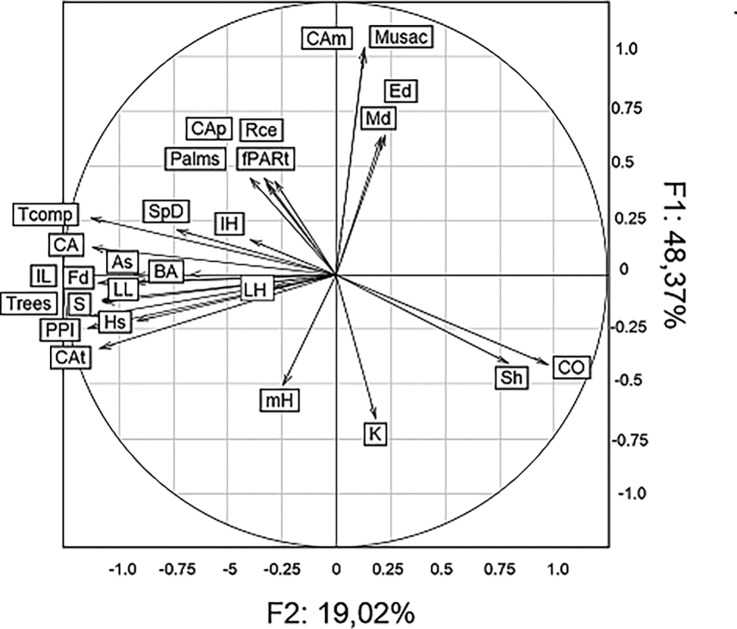
Representation of the PCA carried out on the matrix of 28 variables characterised in each plot: 4 variables for diversity, 6 for composition, 9 for vertical spatial structure, 3 for horizontal spatial structure, and 4 for transmitted radiation.The abbreviations for each variable are explained in Table 1.